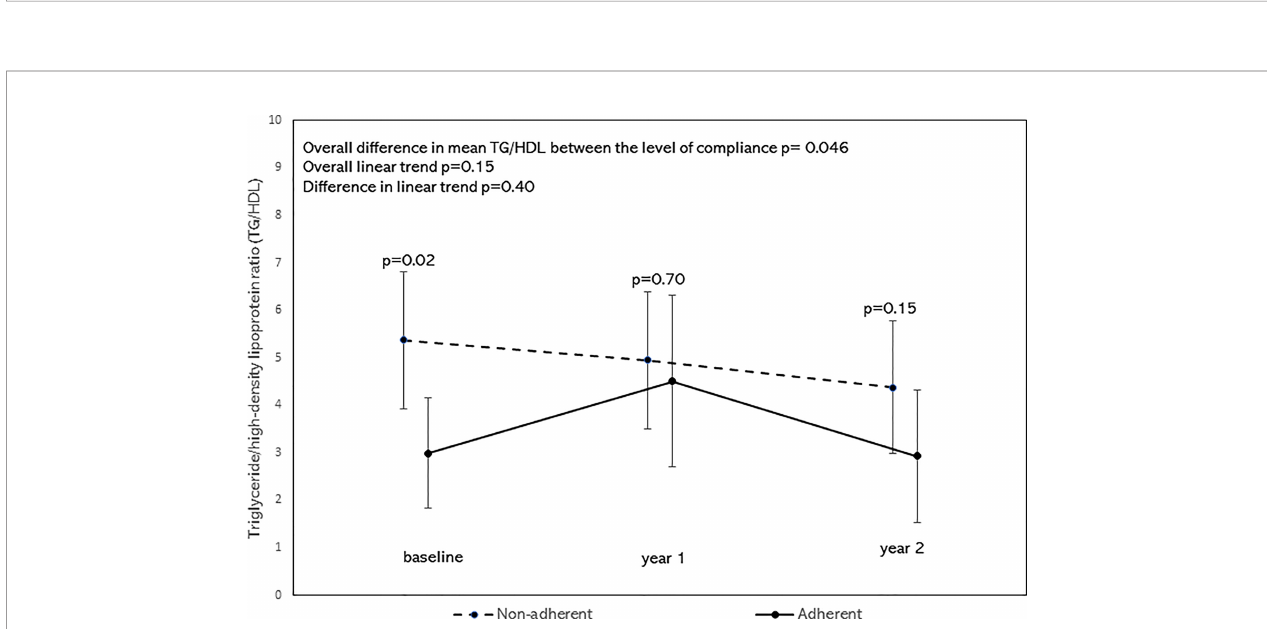
FIGURE 5 | Least square means of triglyceride/high-density lipoprotein ratio (TG/HDL) strati fi ed by Adherence to nutrition visits with 95% con fi dence limits and trend analysis, adjusted for age, sex, race/ethnicity, and BMI-z score. The overall mean of TG/HDL was signi fi cantly lower in the adherent group